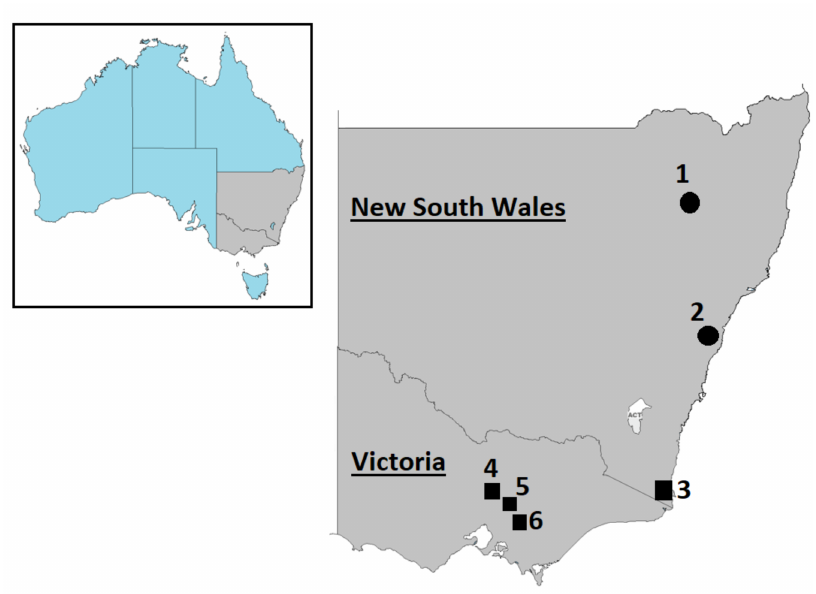
Figure 1. Geographic location of deer (1–6) and cattle (3, 4, and 6) sample collection in southeastern Australia. • indicates sampling sites of serum and plasma tested by high-throughput sequencing, while (cid:4) indicates sampling sites of specimens tested by PCR. (1) Liverpool Plains, (2) Wollongong, (3) Kiah, (4) Outer Melbourne, (5) Yellingbo, (6) Bunyip. ©d-maps.com (25 June